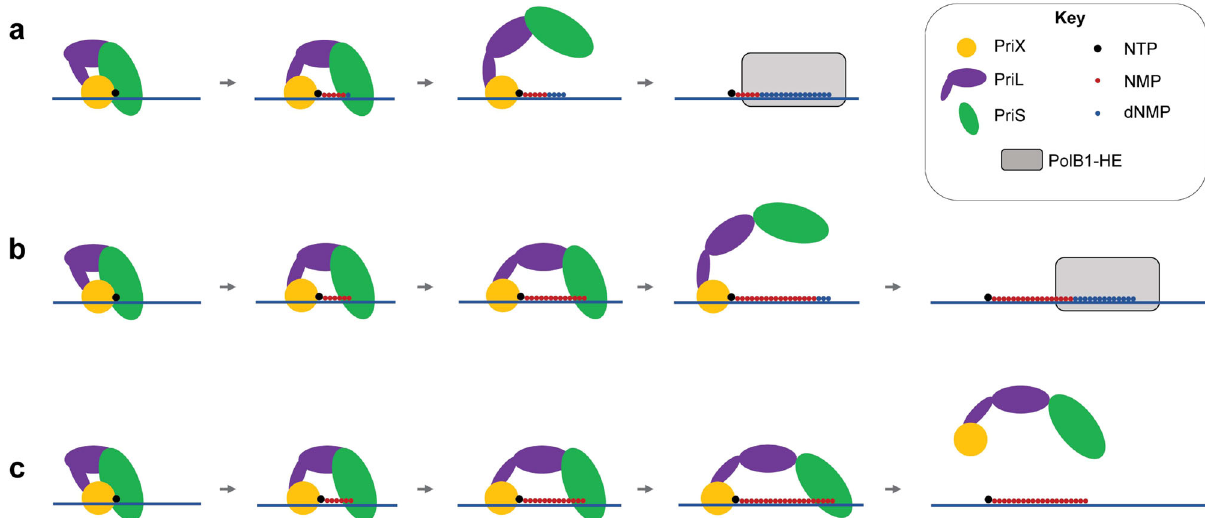
Fig. 7 Model of the primer hand-off. After primase initiates primer synthesis by RNA-synthesis, a favored stochastic deoxyribonucleotide incorporation switches primase to DNA-synthesis. This promotes primase disengagement from the primer and subsequent hand-off to replicative polymerase. a , b A scenario of earlier or later switch to DNA-synthesis, respectively, by primase. c While unfavored, a scenario where primase does not switch to DNA- synthesis. As a back-up failsafe, the caliper mechanism constrains RNA-primer length, halting synthesis. With synthesis halted, primase dissociates from the